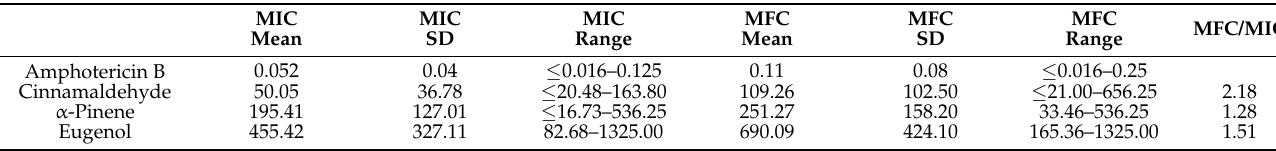
Table 4. Antifungal effects of selected natural compounds against Candida strains evaluated by microdilution Table 3. Summary of the results from microdilution assay.